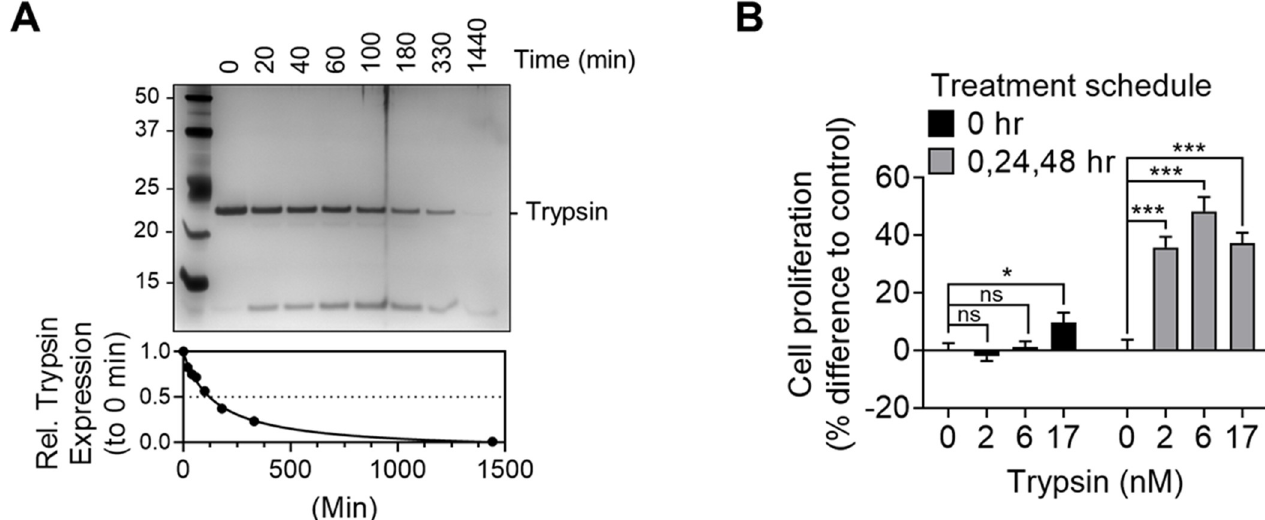
Fig 3. Downregulation of trypsin. ( A) Trypsin (150 nM) in DMEM culture medium was incubated at 37˚C for the indicated durations, after which trypsin expression was analyzed by SDS-PAGE electrophoresis with silver staining; 1 st lane: protein size maker (kDa); T 1/2 (the time for degradation of a half of trypsin) = 122 min. (B) OVCAR-3 cells received one-time stimulation with trypsin and further incubated for 72 h or cells were stimulated with trypsin daily for 72 h, after which cell proliferation was determined by MTS assay. ns: not significant; � : p < 0.05: ��� : p < 0.001 (two tailed, homoscedastic T-test).